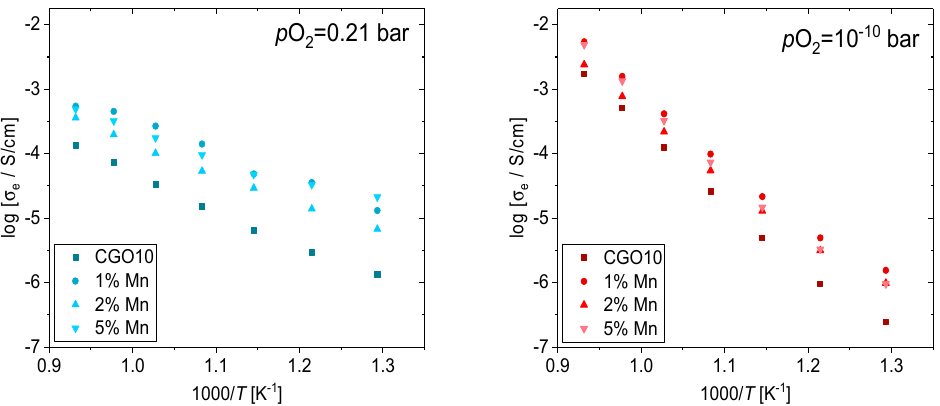
Figure 8. Electronic conductivity at p O 2 = 0.21 bar (blue symbols) and at p O 2 = 10 − 10 bar (red symbols)